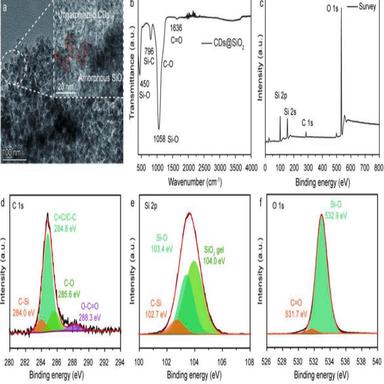
(a) TEM image of CDs@SiO2, (b) FTIR spectrum of CDs@SiO2, (c) XPS pattern of CDs@SiO2, and (d–f) high-resolution XPS spectra of C 1s, Si 2p, and O 1s.